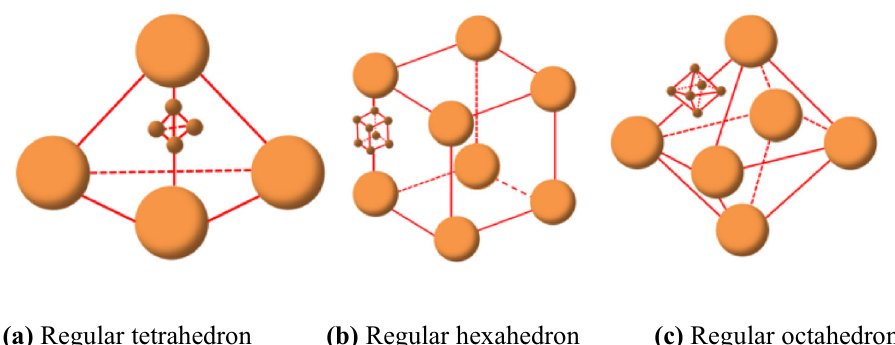
Transformation rule: When at least 3 cementing units are broken, it is considered that the crack penetrates along the particles and appears as damage of the cement member at the next level. (a) Regular tetrahedron